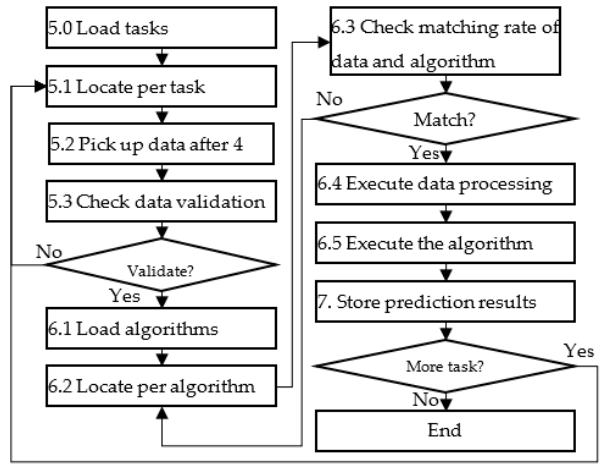
Figure 3. Final algorithm of the Algorithm